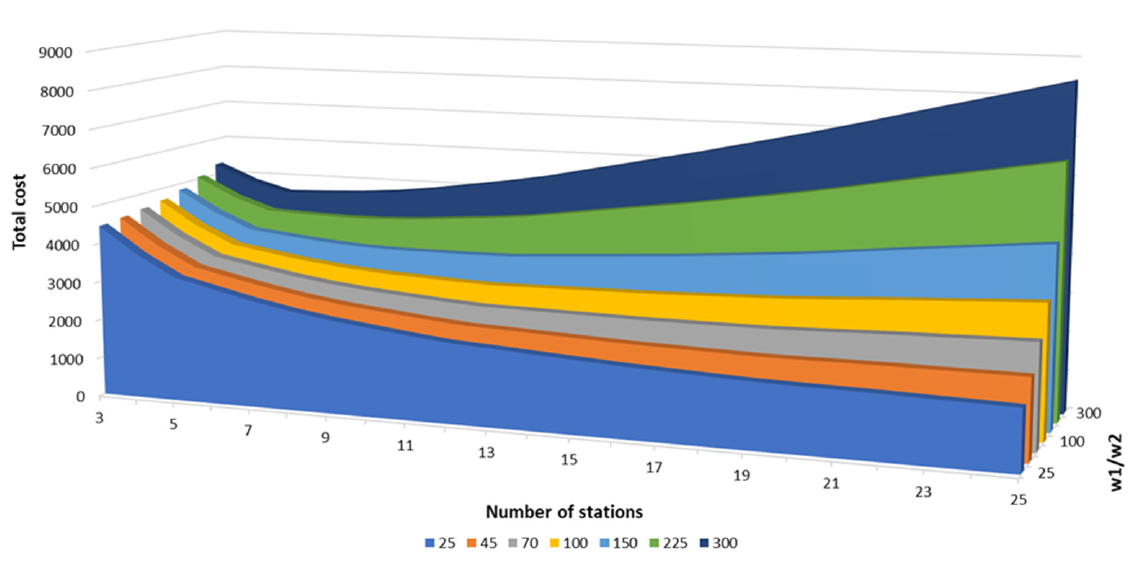
Figure 7. Optimal number of charging stations for different w1/w2 ratios.